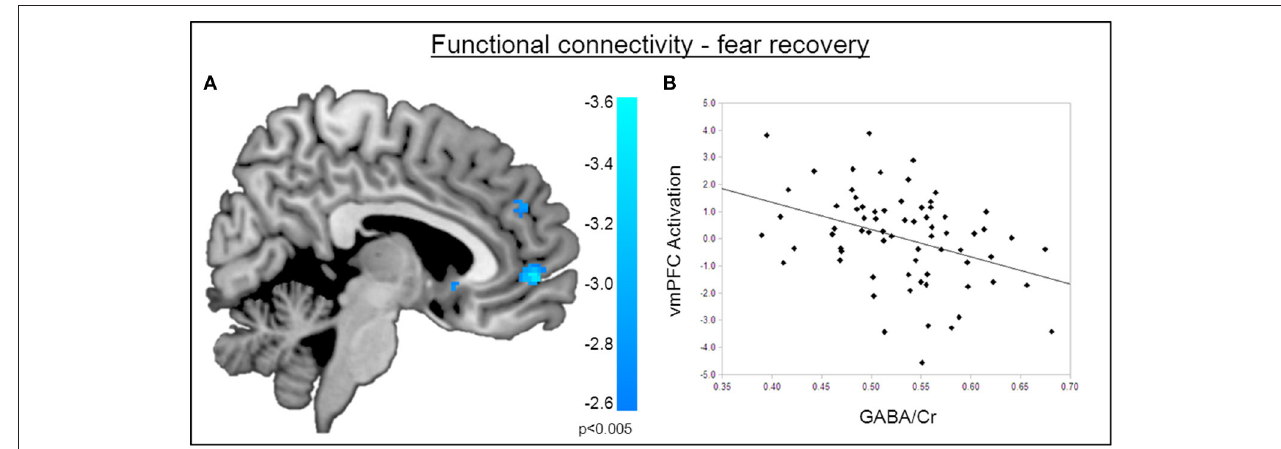
FIGURE 5 | Functional connectivity during the recovery of fear. (A) Psychophysiological interactions with the right amygdala seed region during fear recovery revealed a negative voxel-wise correlation of GABA mediated amygdala-vmPFC connectivity during fear recovery (MNI x,y,z = 2, 52, − 2; P SVC < 0.05). Threshold for displaying the images is set at P = 0.005, uncorrected. (B) Correlation plot of dACC GABA levels and deactivation of the vmPFC showing that high GABA levels are correlated with diminished amygdala-vmPFC connectivity compared to low GABA levels.